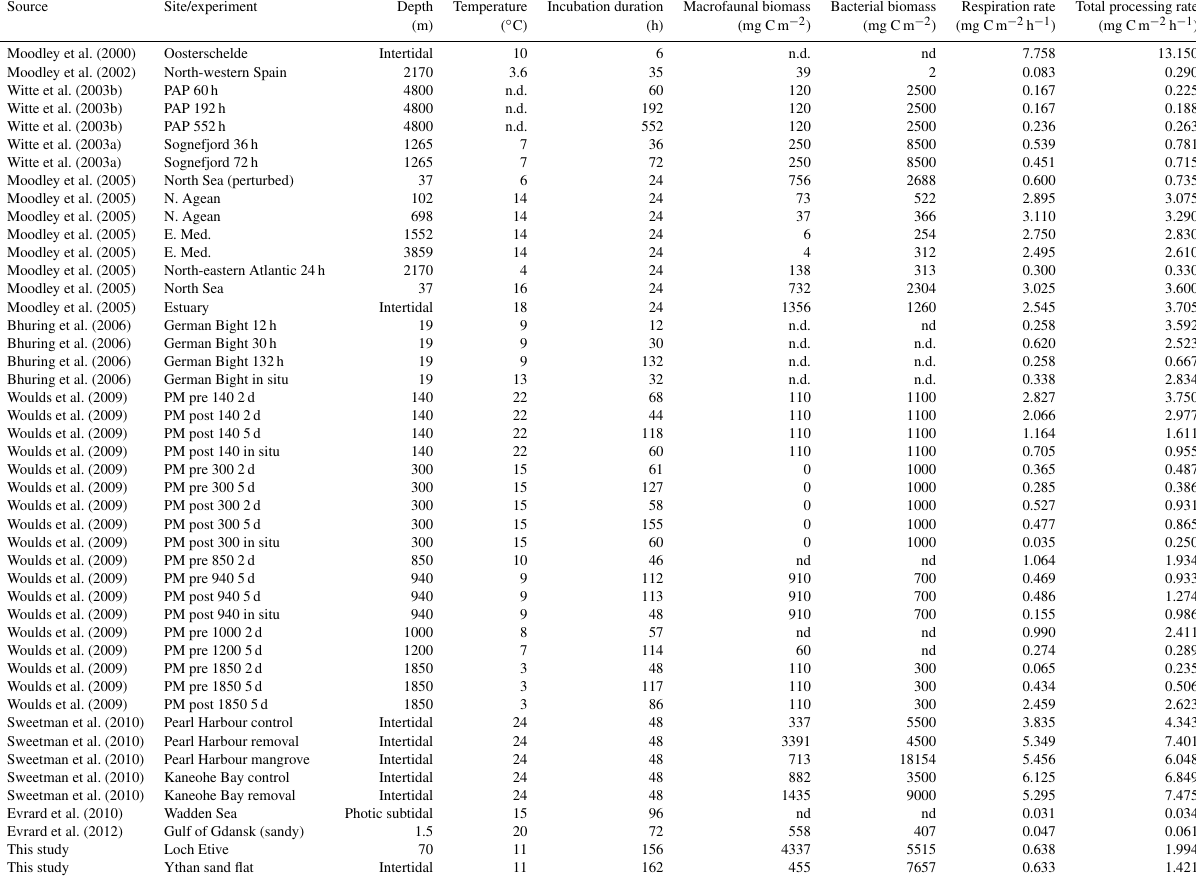
Table 1. Sources and site details of previous isotope tracing experiment data. PAP = Porcupine Abyssal Plain. For Woulds et al. (2009) ex- periments, PM is the Pakistan margin, “pre” and “post” indicate pre- or post-monsoon seasons, and 2d or 5d indicate approximate experiment durations in days. In some other cases experiment durations are indicated in hours